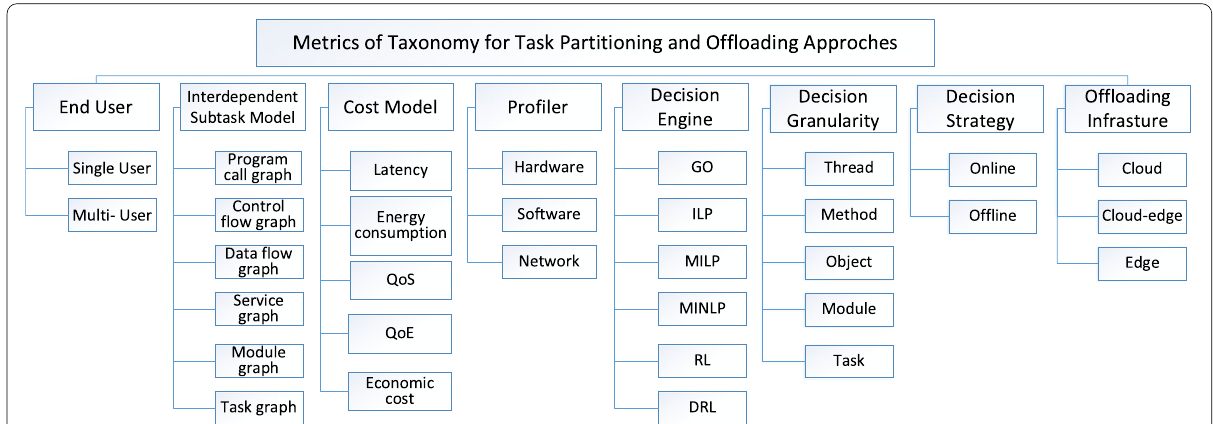
Fig. 9 Comprehensive taxonomy of task partitioning and offloading